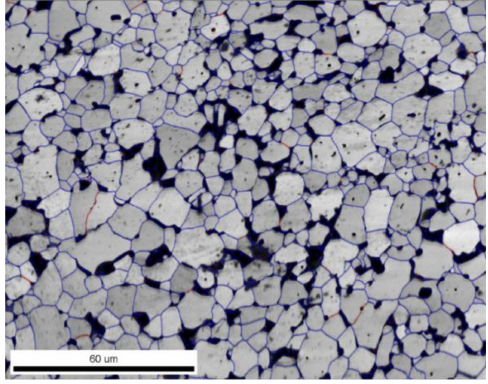
Figure 5. Grain boundaries of the Ti + 20 wt % TiMoC/C composite.